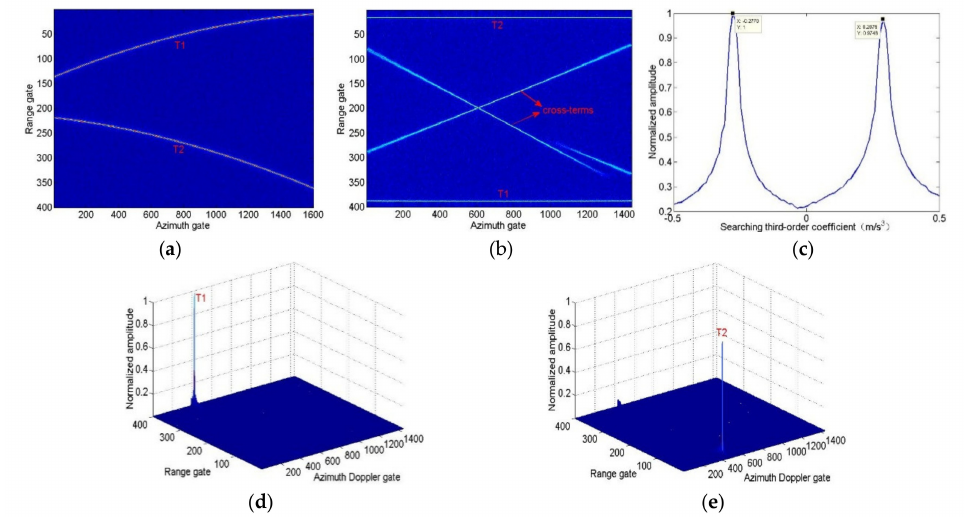
Figure 5. Simulation results of Example 2. ( a ) Target trajectories after range compression. ( b ) Result after RM correction. ( c ) Searching result of third-order coefficient. ( d ) Final focusing result of T1. ( e ) Final focusing result of